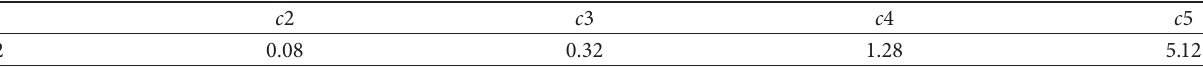
Table 4: Set of coefficients of damping of the compliant ground ( × 10 4 N · s/m). c 1